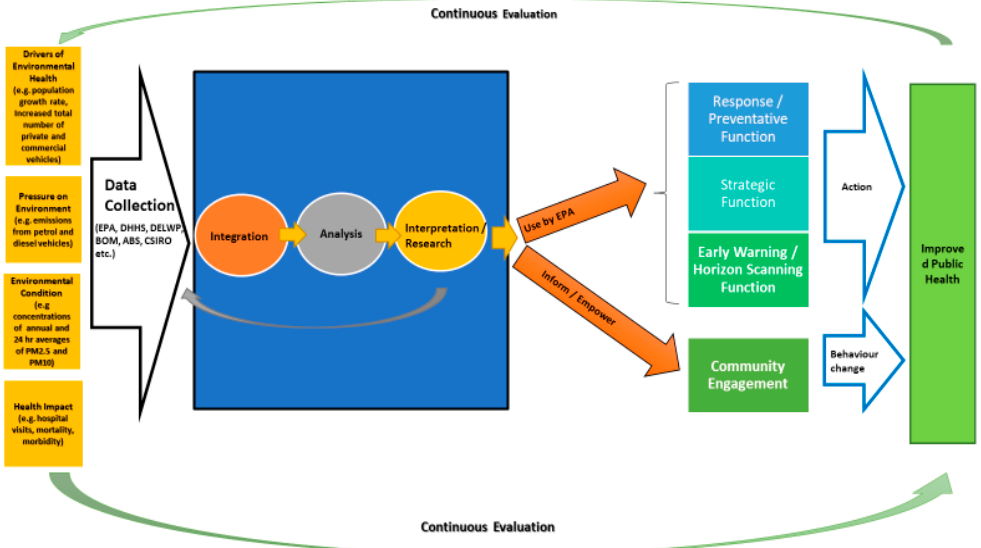
Table 3. Application of the DPEHA conceptual framework to anthropogenic PM 2.5 emissions.